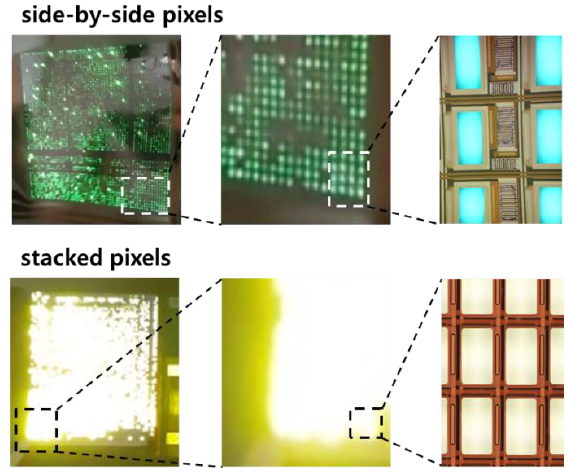
Figure 7. Comparison of the stacked pixels with the side-by-side pixels in the AMOLED fabricated on the PET fabric substrate; the aperture ratio of 48% with the stacked pixels (pixel pitch: 1.0 mm × 0.77 mm, OLED area: 0.76 mm × 0.49 mm) is clearly identified with 19% of the side-by-side case (pixel pitch: 1.6 mm × 1.6 mm, OLED area: 1.04 mm × 0.47 mm).